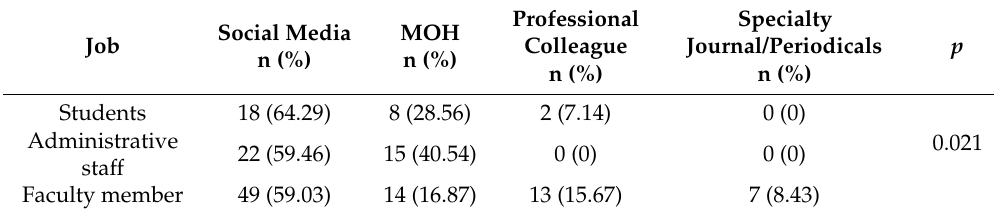
Table 5. Frequencies and percentage for the Main Source of COVID-19 Information for selected Job Categories.